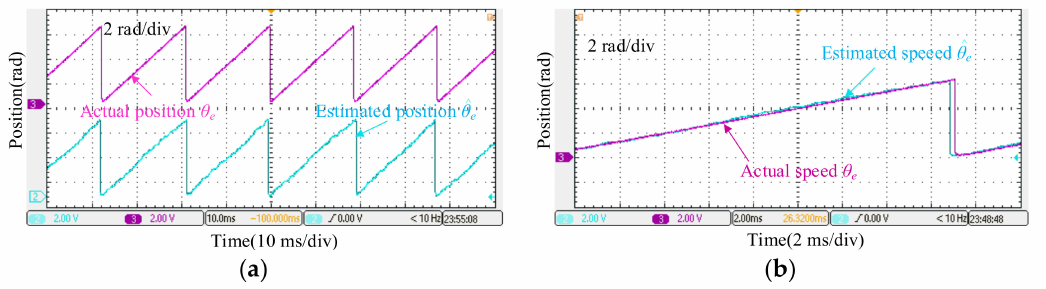
Figure 13. Actual position and estimated position employing the traditional second-order SMO method when the motor operates at 800 rpm ( a ) separated waveform; ( b ) overlapped waveforms.